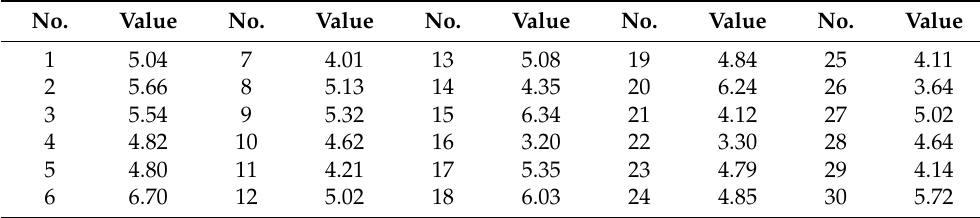
Table 6. Objective function